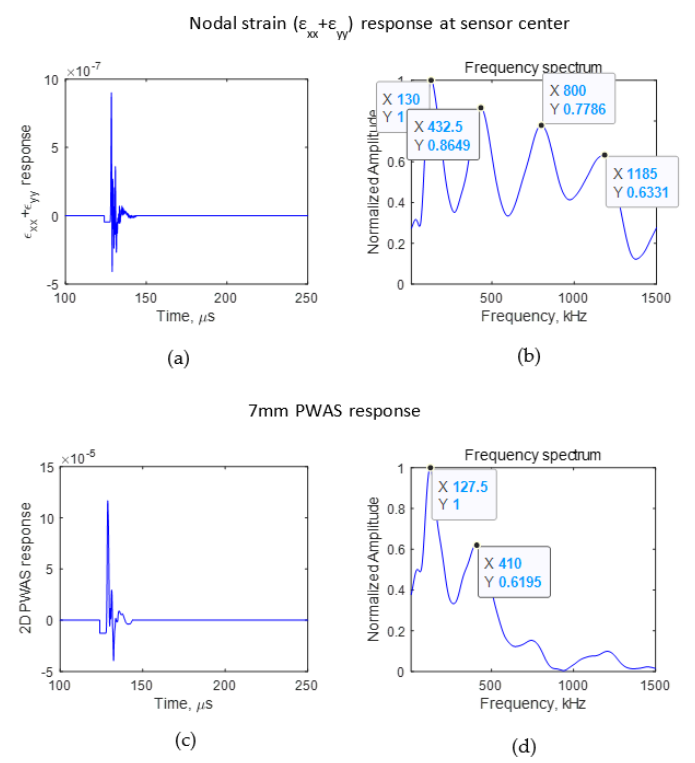
Figure 7. FEM simulation AE signal sensed at 25 mm in the case of an 8 mm crack. ( a ) Nodal in-plane strain response; ( b ) frequency spectrum of nodal in-plane strain response; ( c ) 7 mm PWAS response ( d ) frequency spectrum of 7 mm PWAS response.